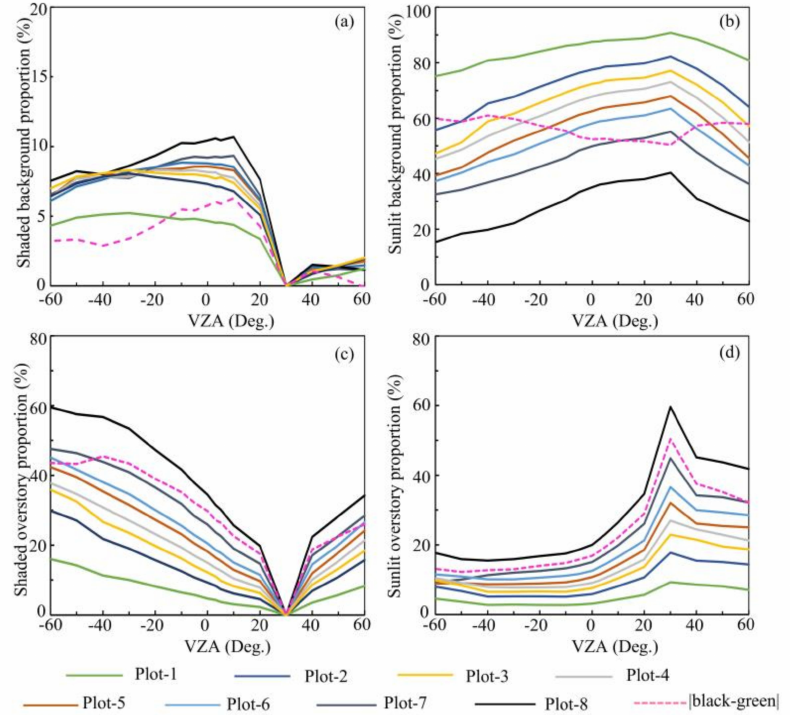
Figure 12. Graphs showing the variations of the four forest component proportions including shaded forest background (inset a ), sunlit forest background (inset b ), shaded overstory (inset c ), and sunlit overstory (inset d ) under di ff erent view zenith angles (i.e., from –60 ◦ to 60 ◦ ) in the solar principal plane with the solar zenith angle of 30 ◦ for eight forest plots. The canopy covers are 12%, 23%, 35%, 46%, 58%, 71%, 83%, and 93% for forest plots 1 – 8, respectively. Red-dashed lines represent the increments of forest component proportions between forest plots 1 and